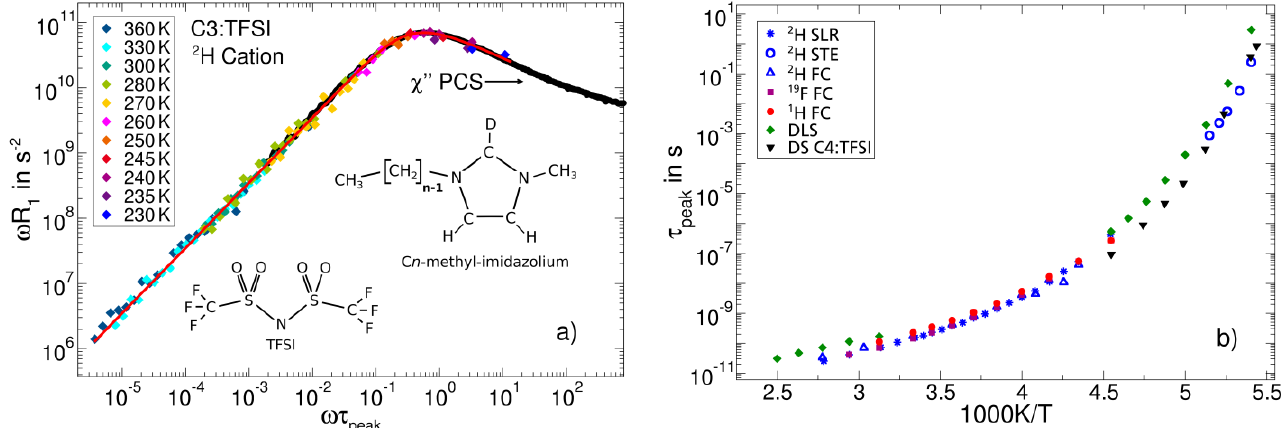
Figure 6. Reorientation dynamics of an ionic liquid comprised of 1-propyl-3-methyl-imidazolium cations (C3) and bis(trifluoromethylsulfonyl)imide (TFSI) anions: ( a ) 2 H NMR susceptibility master curve for the selectively deuterated cation, constructed from FC and HF data at the indicated temperatures (colored symbols), together with the PCS susceptibility (black symbols) [111]. The red line is a CD fit of the NMR data. ( b ) Correlation times of cation reorientation from FC 1 H and 2 H relaxometry and from 2 H stimulated-echo experiments (STE) [100], and of anion reorientation from FC 19 F relaxometry together with data from DLS [111] and DS [112] studies, the latter for a slightly different ionic liquid consisting of 1-butyl-3-methyl-imidazolium cations (C4) and TFSI anions.